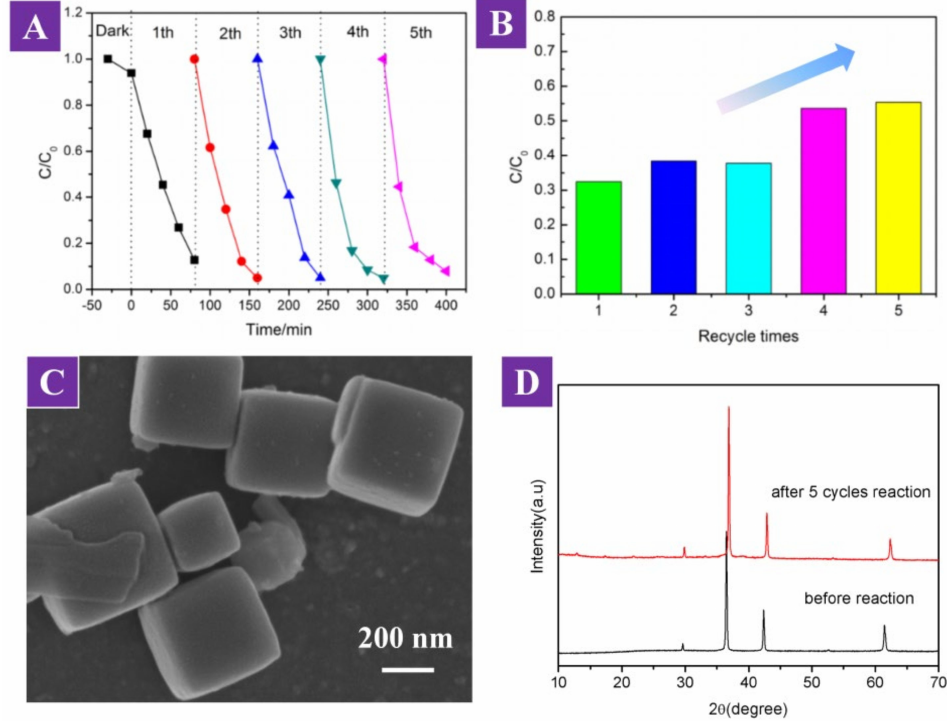
Figure 8. ( A )The recycling experiments of c-Cu 2 O(100) nanocrystals toward the degradation of MO. ( B ) Comparison of the corresponding MO degradation after 20 min. ( C ) SEM images and ( D ) XRD of c-Cu 2 O(100) nanocrystals after five